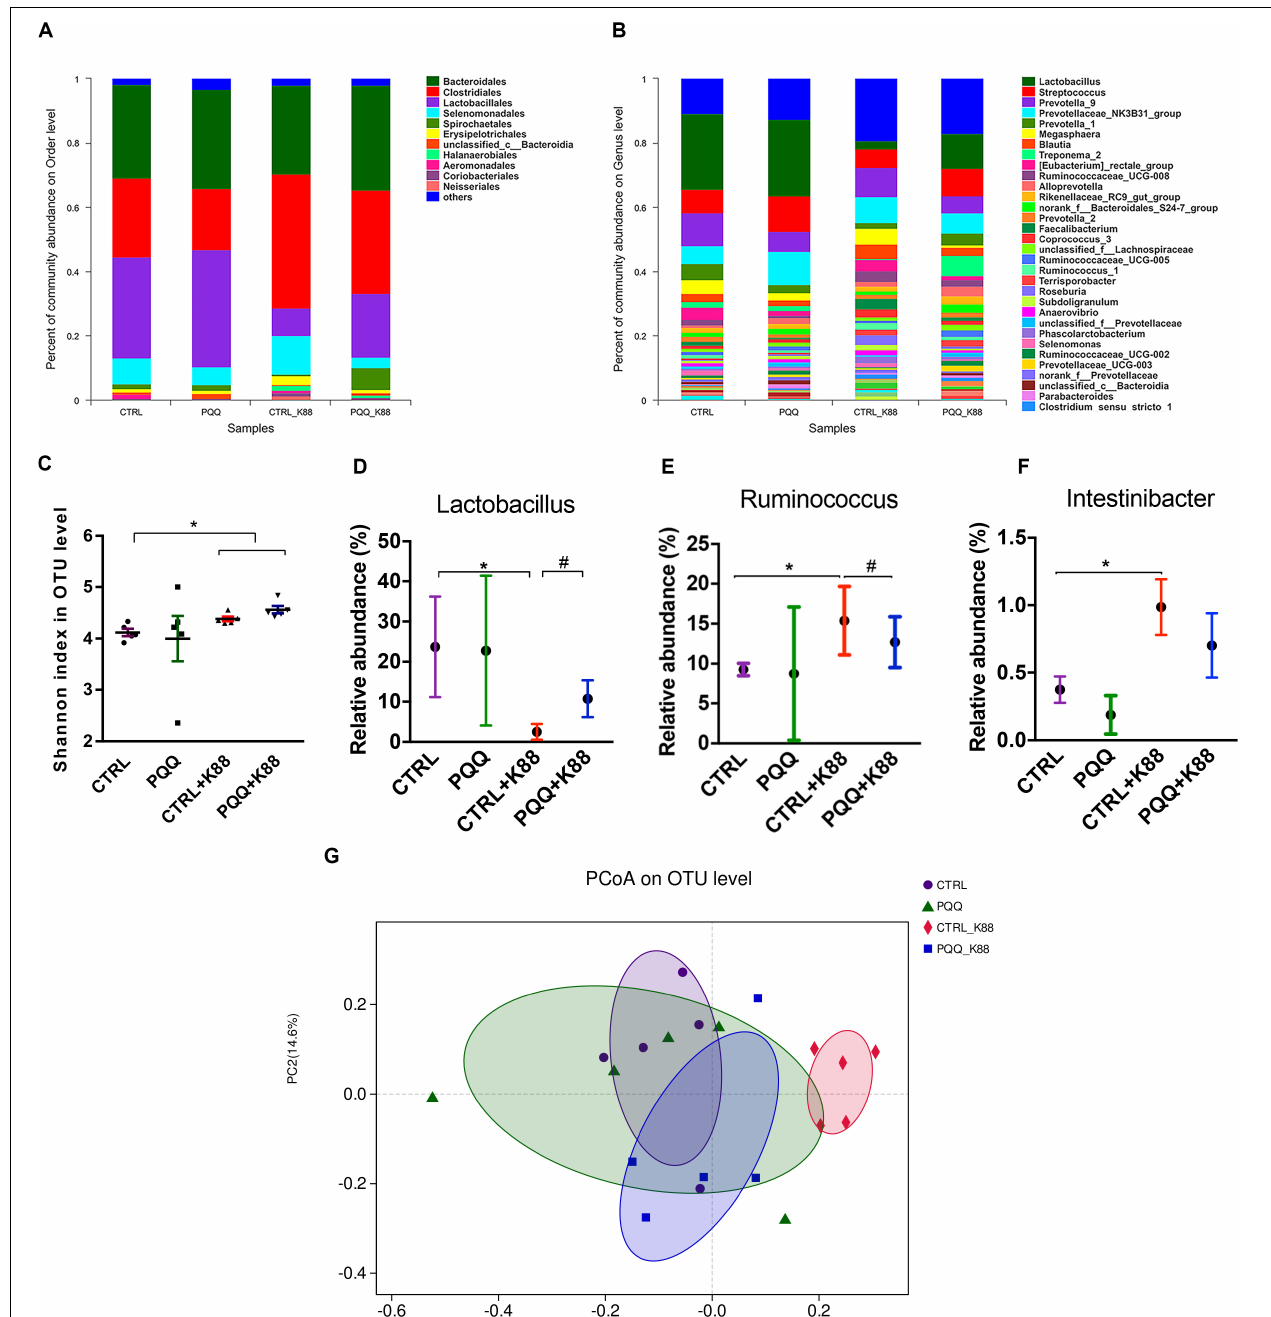
FIGURE 4 | Colonic microbiota composition after PQQ supplementation in ETEC K88-challenged piglets. Relative contribution of order (A) and genus (B) in the colon of piglets in the CTRL, PQQ, CTRL + K88, and PQQ + K88 groups. (C) The α diversity, including Shannon curves, shows the diversity and richness of colonic microbiota in all groups. (D–F) The relative abundances of selected bacterial genera in the four groups are shown. (G) The dispersion of each sample in the four groups is reflected by the β diversity, PCoA score plot, and Bray–Curtis score plot. The abundance of taxa in the community is indicated by the diameter of each circle. Values are presented as mean ± SEM; n = 5. * denotes a significant difference ( P < 0.05) compared with the control group. # denotes a significant difference ( P < 0.05) compared with the CTRL + K88